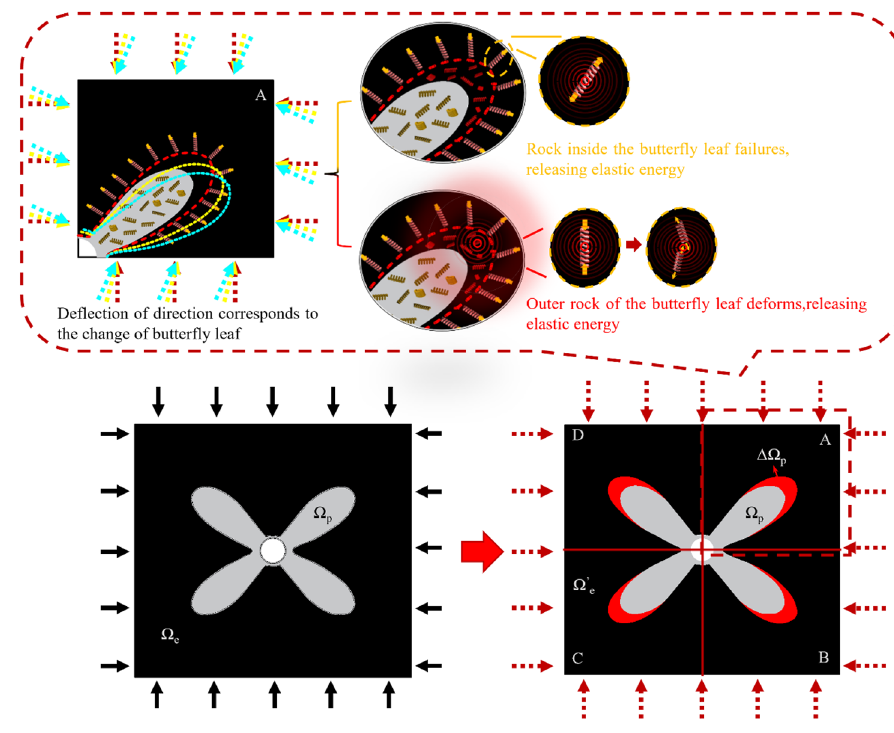
Fig. 9 The dynamic energy release process of rockburst caused by butterfly failure